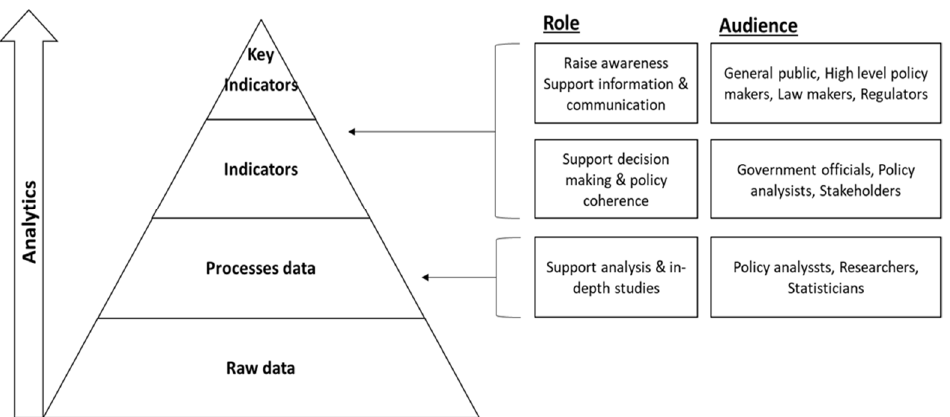
Figure 3. Information Pyramid as a tool for an Improved Government Decision-Making